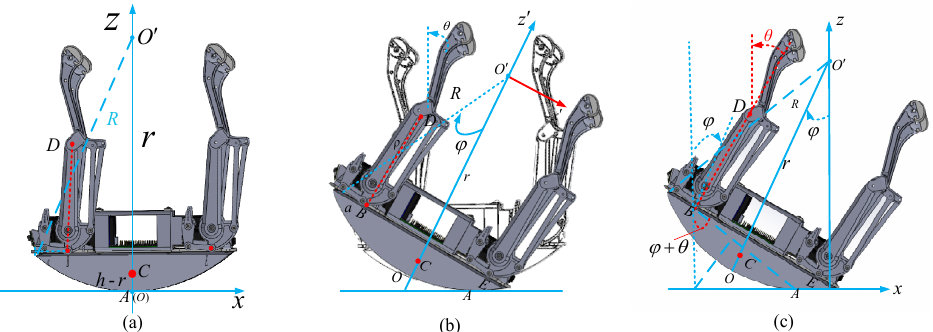
Figure 4. The coordinate system of the quadruped robot. ( a ) The initial state of contact between the shell and the ground after the robot is overturned. ( b ) The solid line indicates the positional state of the robot after the rotation, and the dashed line indicates the positional state of the robot in the initial state. ( c ) The positional state of the robot after the rotation.